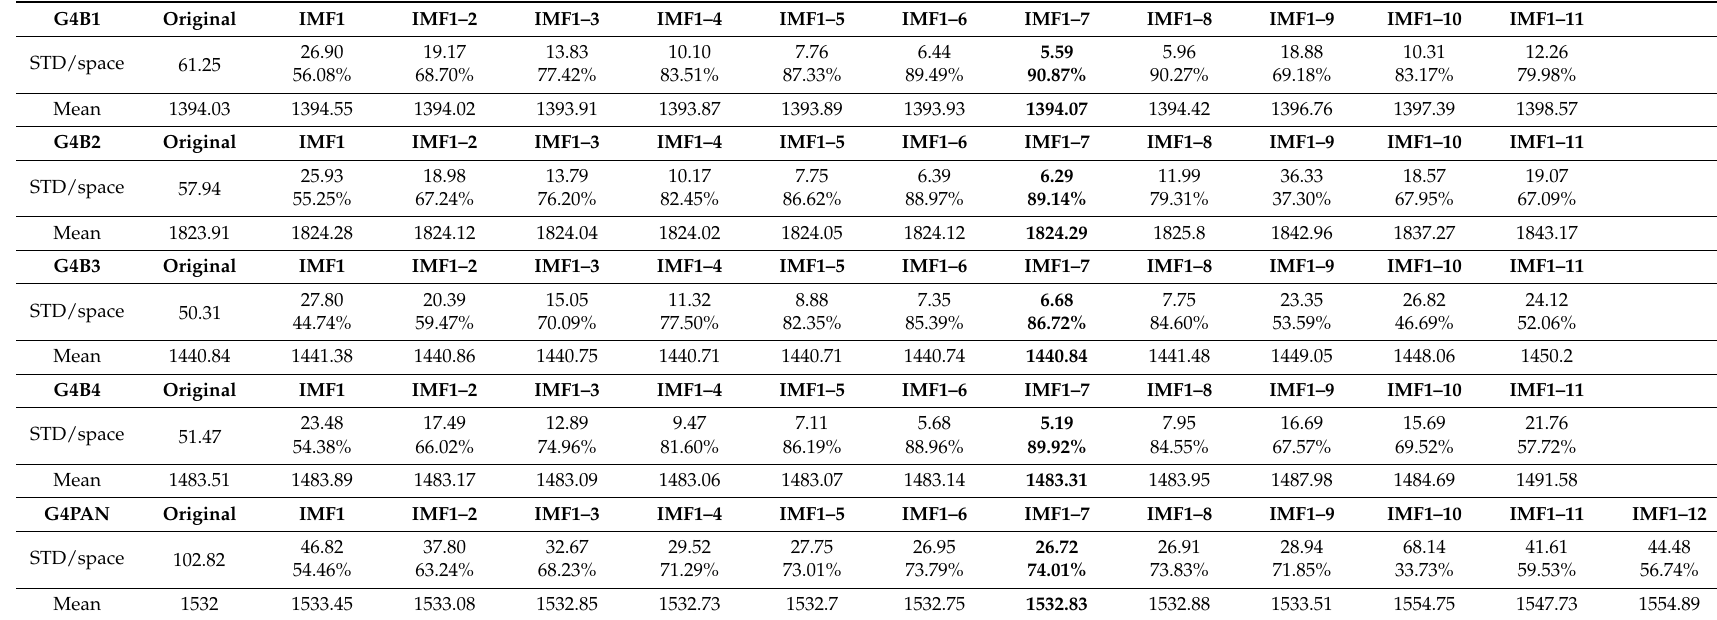
Table 5. Same as Table 3, but for gain setting